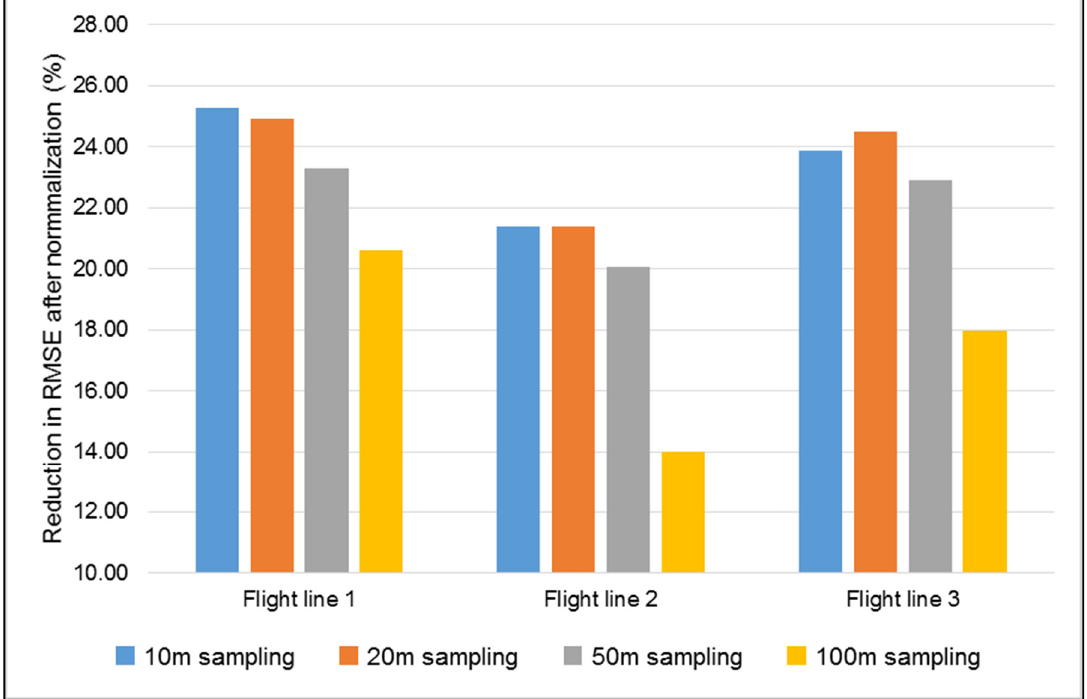
Figure 8. The percent (%) decrease in RMSE of three evaluated flight-lines after radiometric normalization at four different sampling intervals.